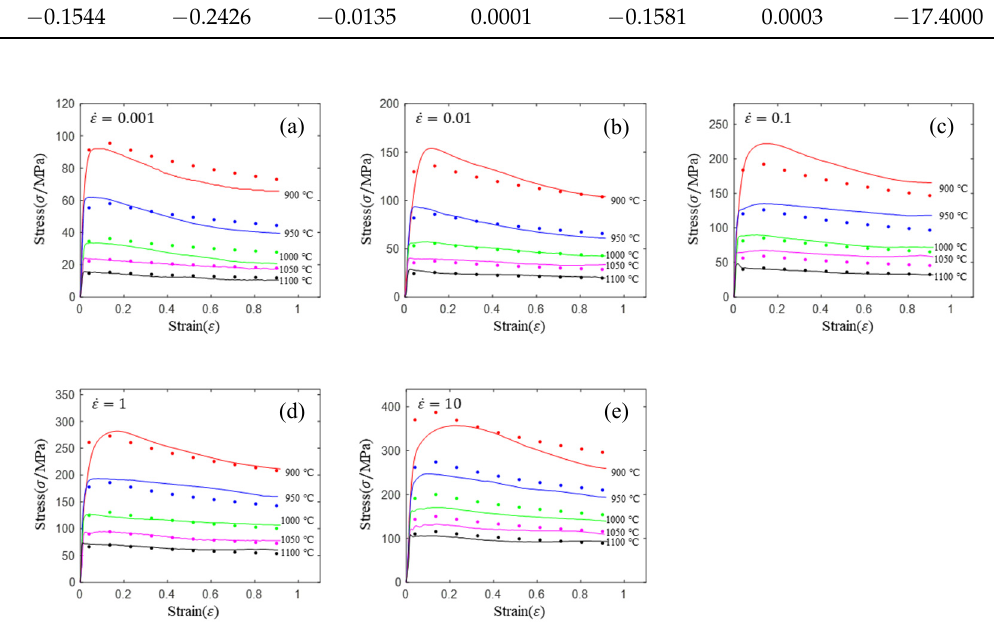
Table 4. Multiple linear regression results of material parameters.